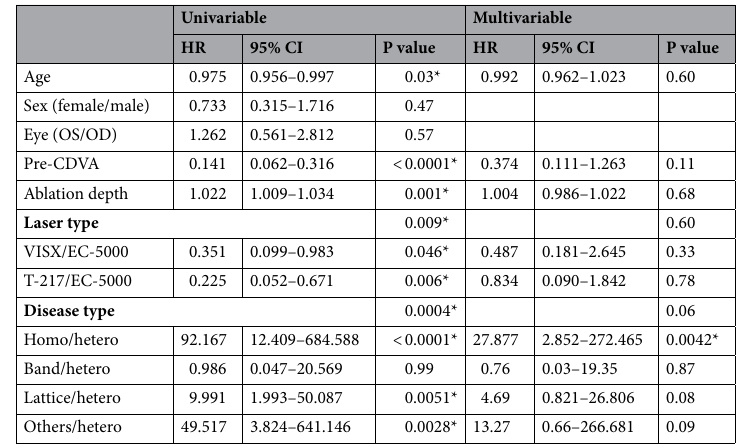
Table 3. The cox proportional hazard model of univariable and multivariable for disease recurrence. Multivariable model is adjusted for age, pre-CDVA, ablation depth, laser type and disease type. CI confidence interval. *P <